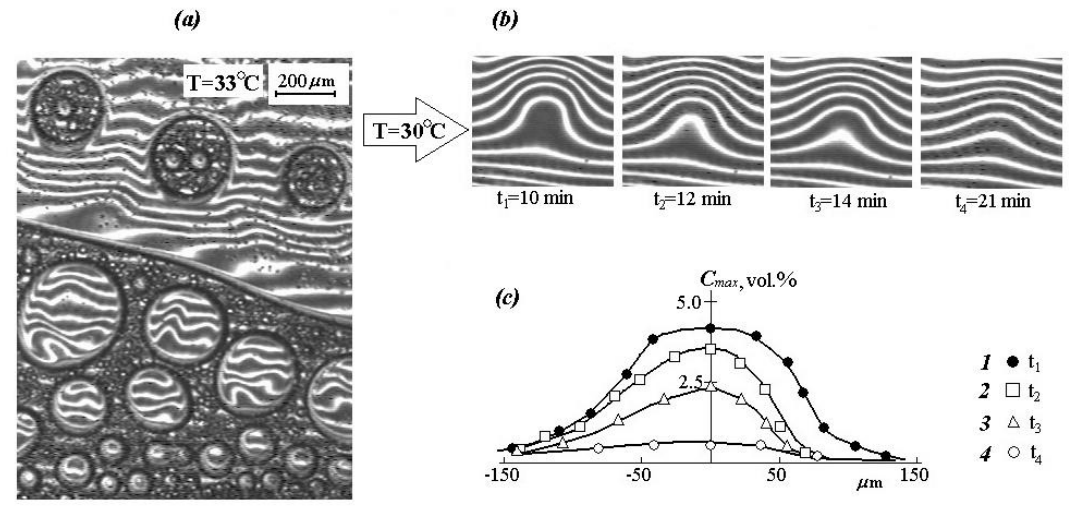
Figure 8. ( a ) Maturation of the PVME phases, ( b ) kinetics of phase dissolution upon transition through ( c ) the binodal curve and their amplitude: 1— t 1 = 10 min; 2— t 2 = 12 min; 3— t 3 = 14 min; 4— t 4 = 21 min.